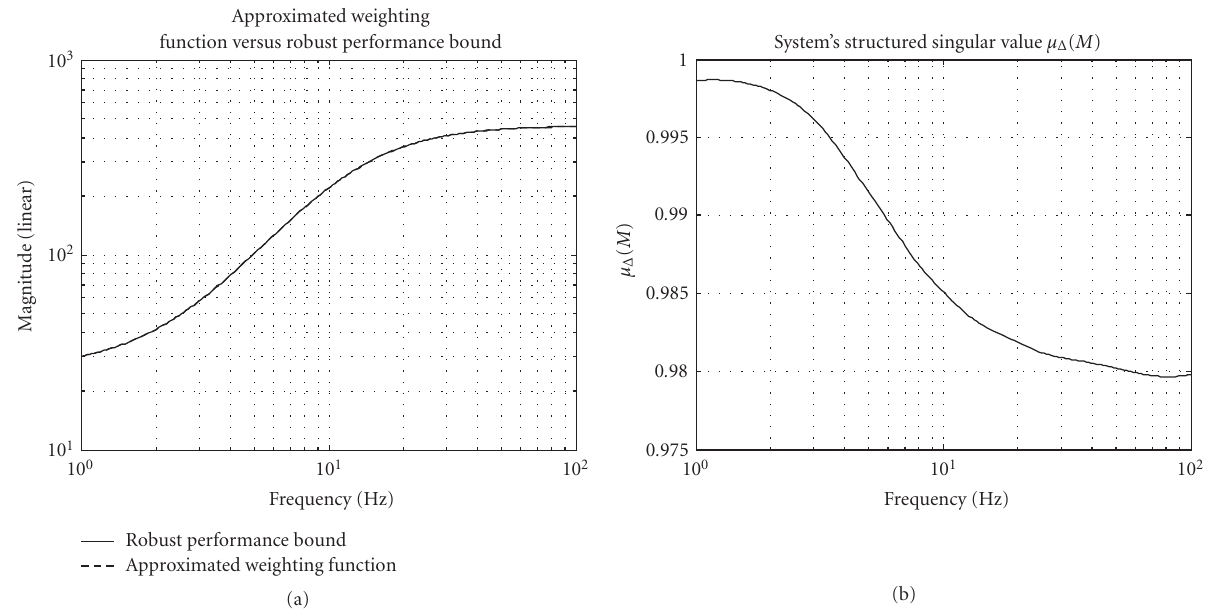
Figure 7: (a) The robust performance bound and the approximated weighting function W K , (b) with its respective structured singular value plot for a limited frequency range.